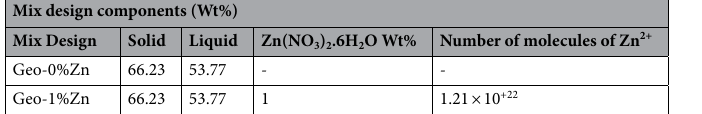
Table 3. Granite-based mix designs examined for pumping time.